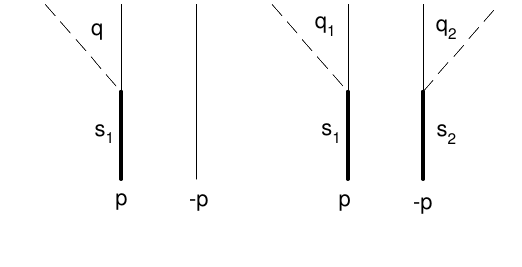
Figure 1. Kinematics of the N ∆ (left) and ∆∆ (right) decays. The relative momenta q i between the pion and nucleon are given by √ √ + (cid:22) 2 + + M 2 with s i = q 2 q 2 ( i ) ( i ) p s i the internal energy of the ∆